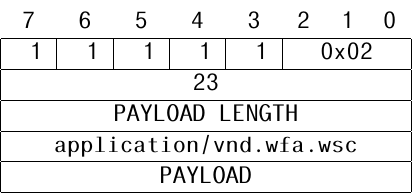
Table 2. Actual NDEF Short-Record